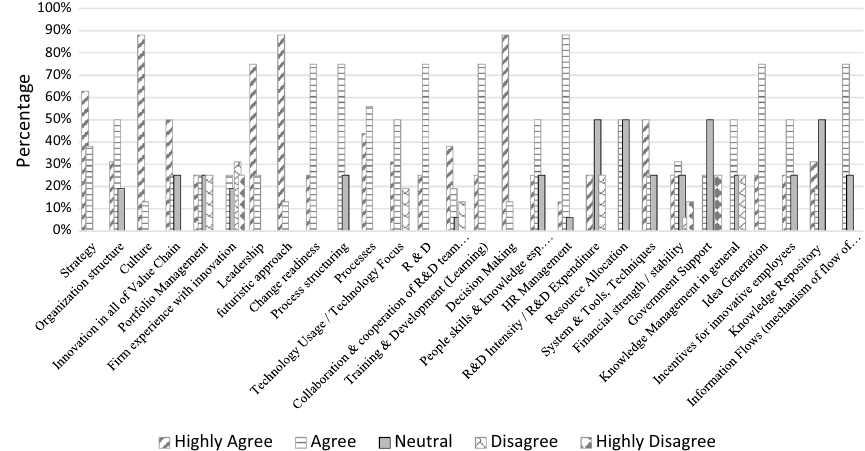
Fig. 4 Survey results related to organizational